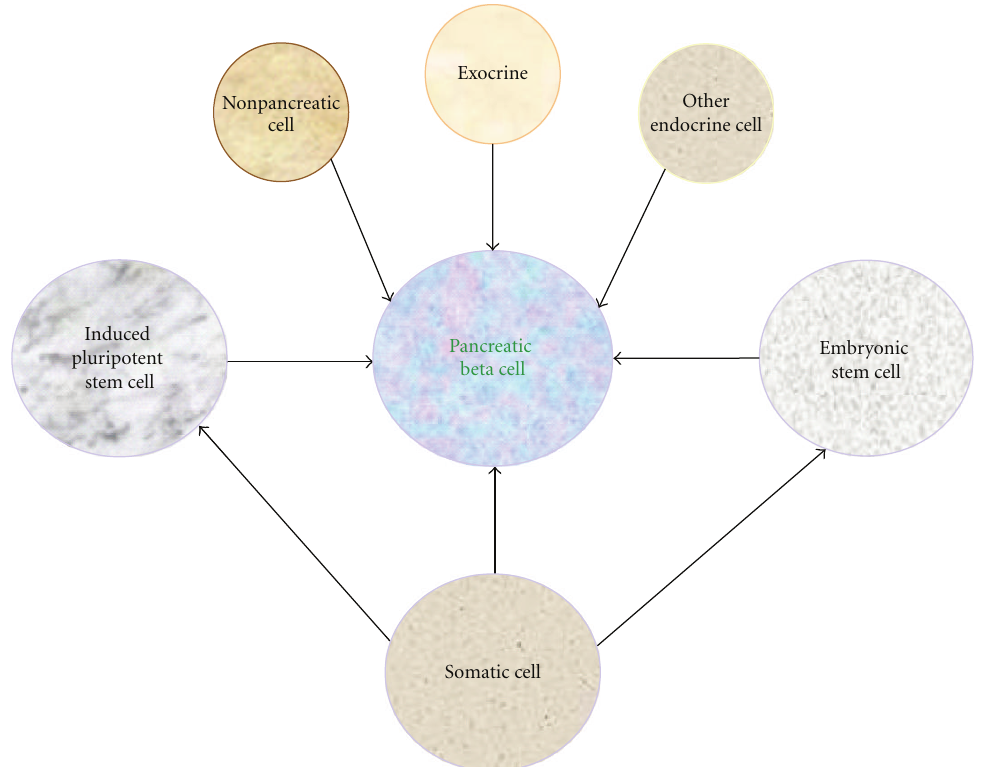
Figure 1: Generation of pancreatic beta cells. New beta cells can be generated by manipulation of di ff erent cell sources, such as from other endocrine, exocrine, and nonpancreatic cells, induced pluripotent stem cells, embryonic stem cells, and somatic cells.